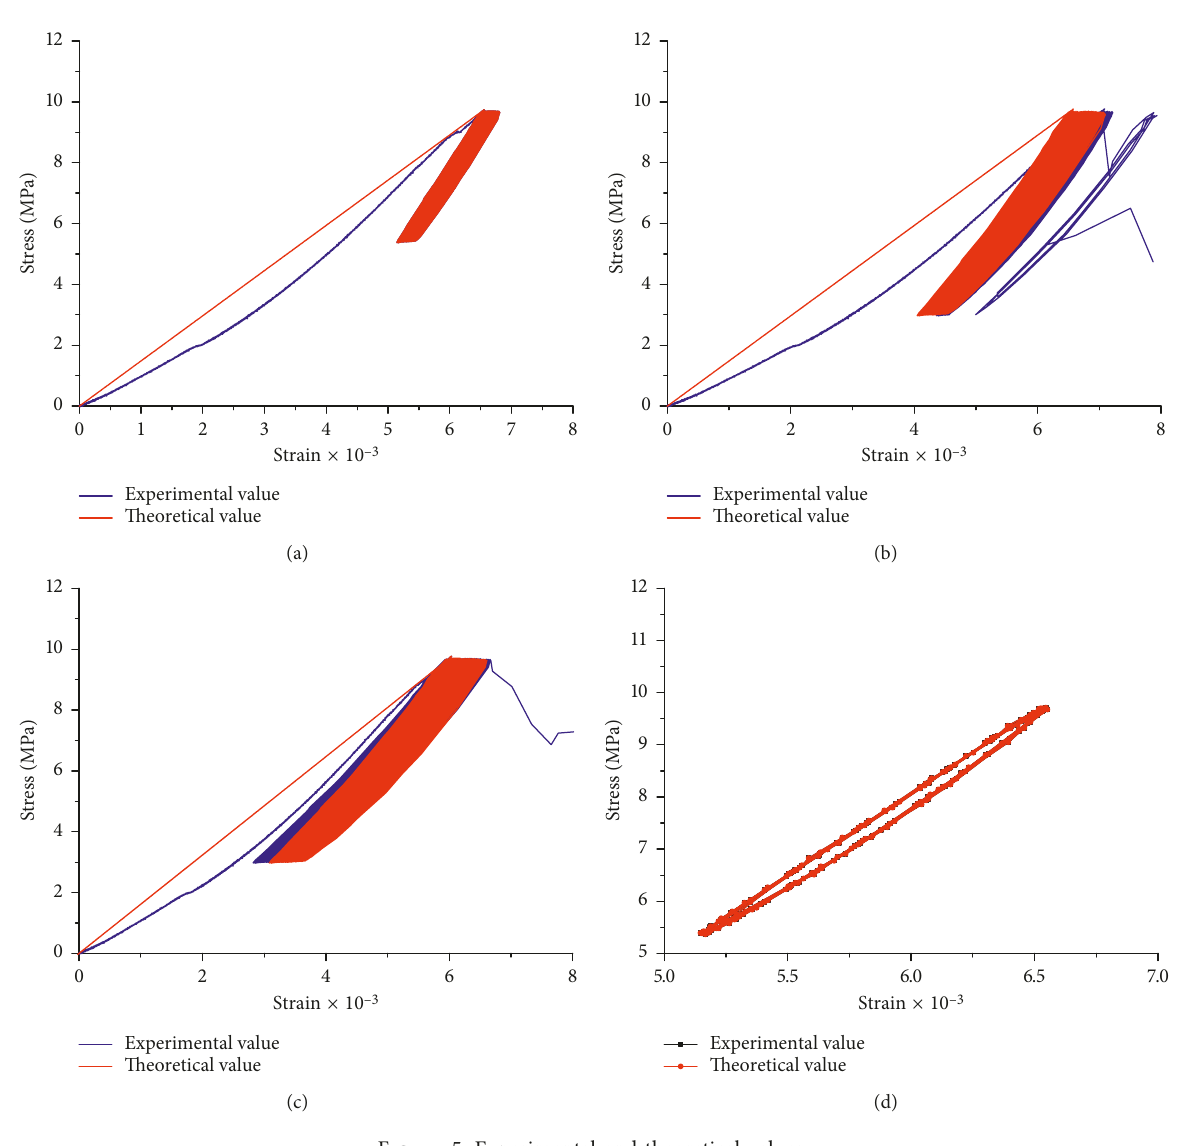
Figure 5: Experimental and theoretical